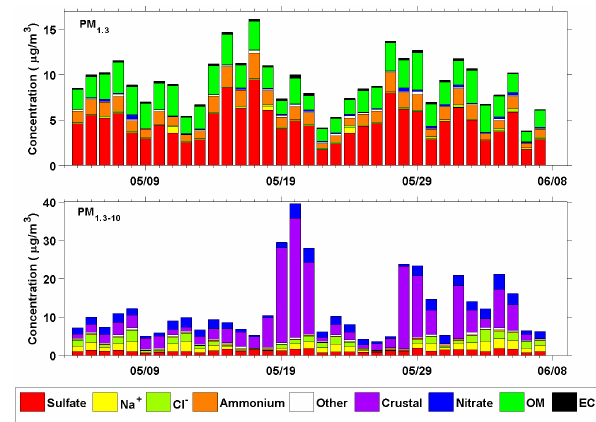
Fig. 7. Daily average of PM 1 . 3 and PM 1 . 3 − 10 during the study, based on filter measurements. OM was calculated as OC × 2.2 ac- cording to Hildebrandt et al. (2010). Crustal concentration is cal- culated using iron as a surrogate according to Sciare et al. (2005). Other is the sum of PO 3 − and K + 4